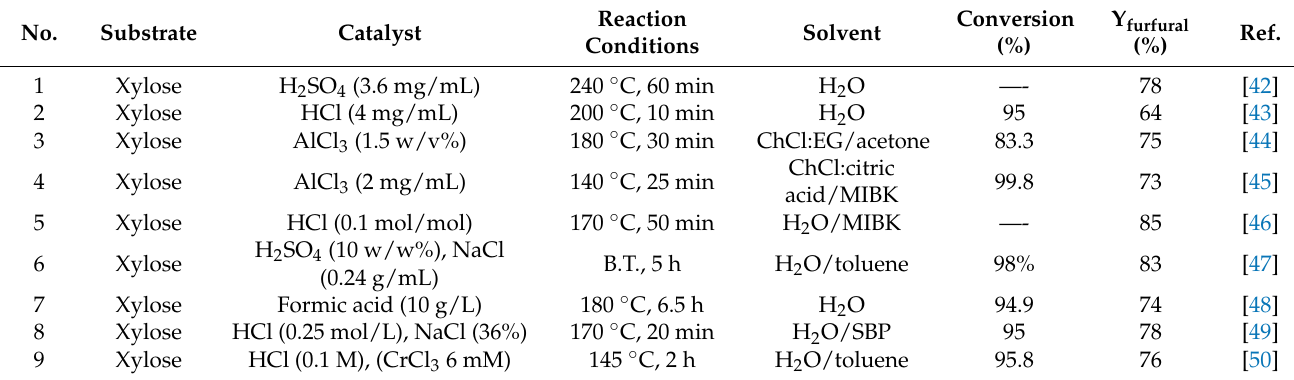
Table 1. Production of furfural from carbohydrate substrates over different homogeneous catalysts.